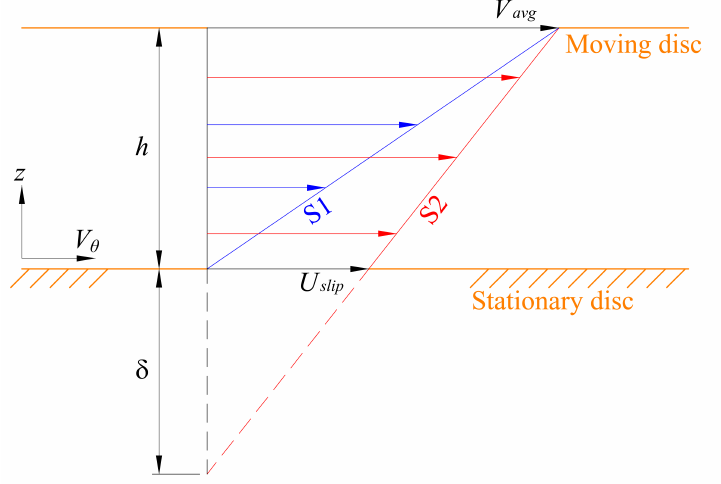
Figure 21. Schematic diagram of velocity profiles between fixed and moving plates in case of slip and no slip at fluid-solid interface. From Samaha et al.